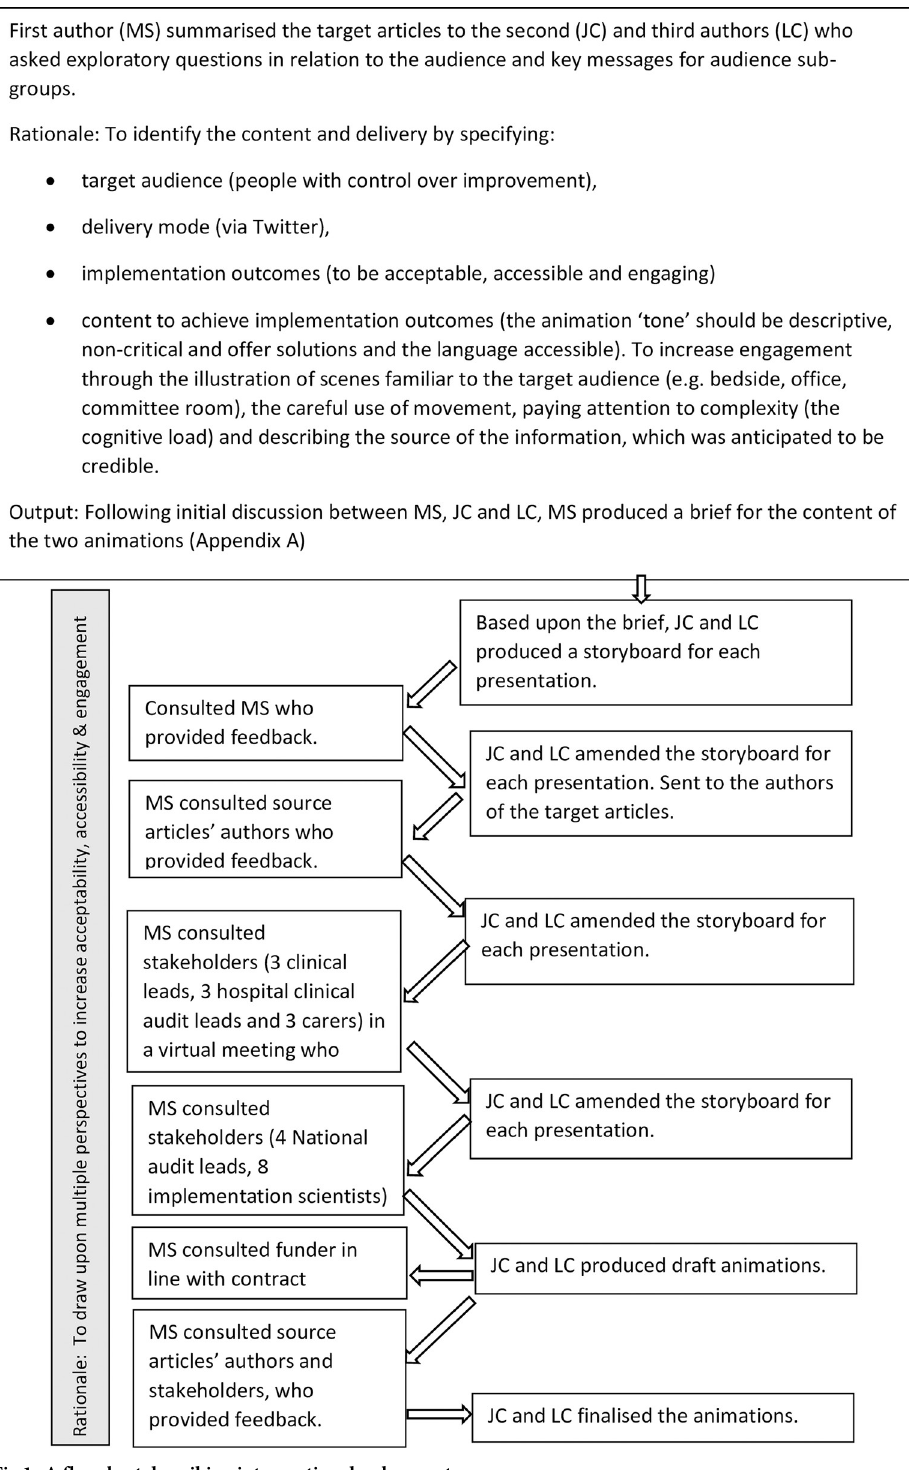
Fig 1. A flowchart describing intervention